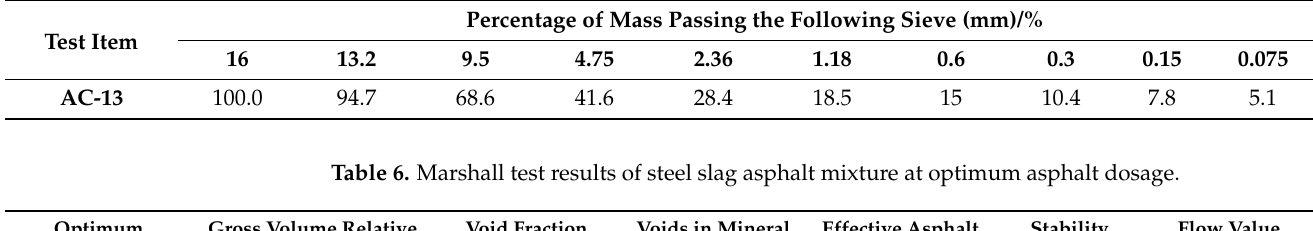
Figure 3. Asphalt mixture grading curve. Table 5. Mass passing percentage of graded sieve.